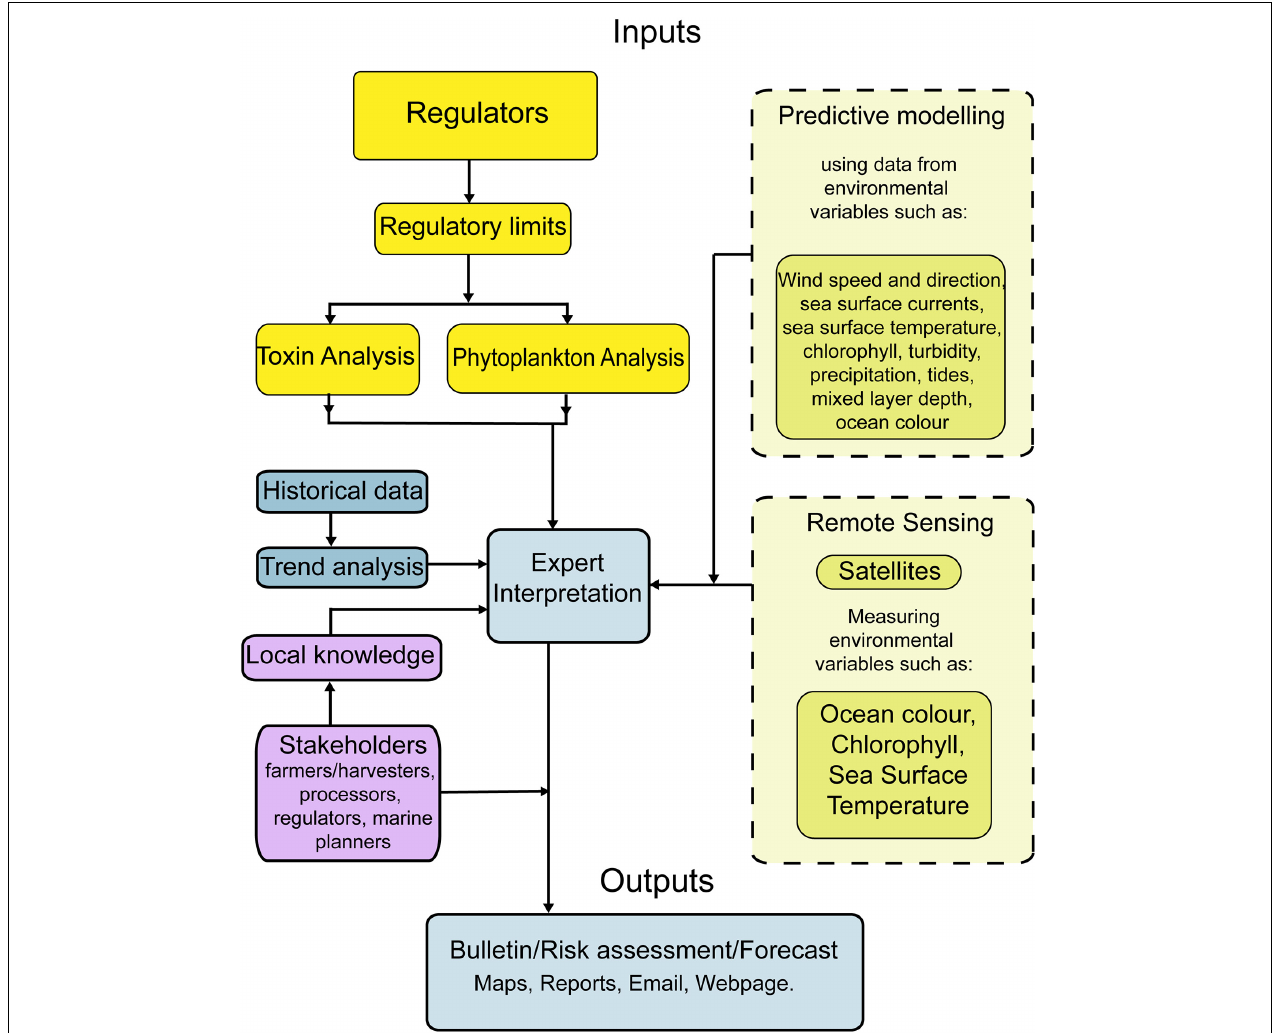
FIGURE 4 | Data streams that contribute to the expert interpretation based HAB/biotoxin forecast.